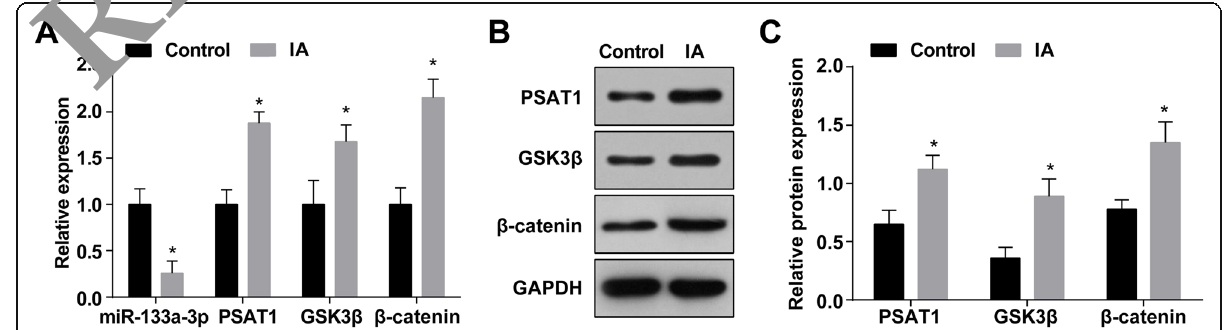
Fig. 1 MiR-133a-3p expression is decreased and the PSAT1, GSK3 β , and β -catenin expression is increased in IA tissues. a Expression of miR-133a-3p, PSAT1, GSK3 β , and β -catenin in the IA group and the normal group. b Protein band of PSAT1, GSK3 β , and β -catenin expression. c Protein expression of PSAT1, GSK3 β , and β -catenin in the IA group and the normal group by western blot assay. n = 75, * P < 0.05 vs. the control group. Measurement data were depicted as mean ± standard deviation, and comparisons between two groups were conducted by independent sample t